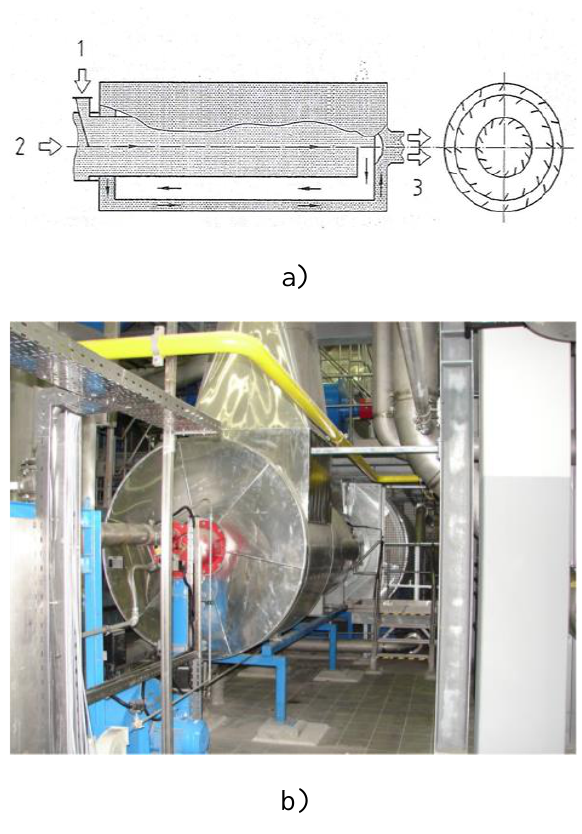
Figure 2. Drum drier at CWWTPL: a) scheme of direct thermal process system (1 - input of wet material, 2 - input of hot off-gases, 3 - output of mixture of pellets, flue gases and evaporated water), b) picture of the